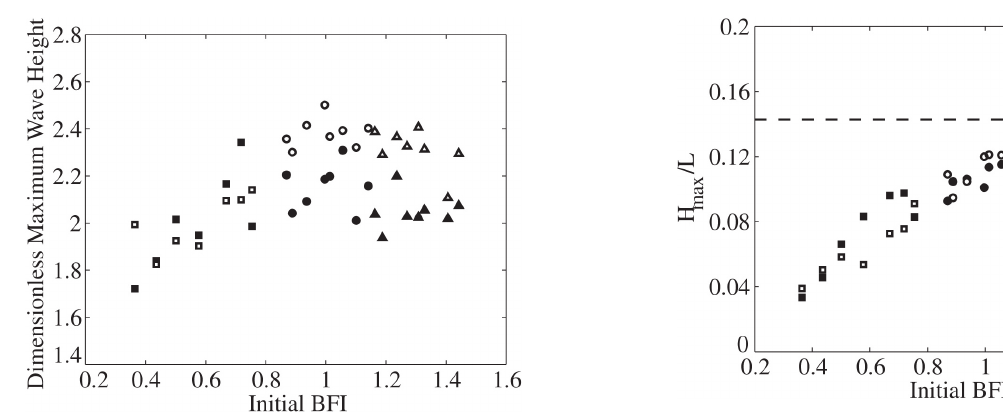
Fig. 8. Dimensionless maximum wave height vs. initial BFI.